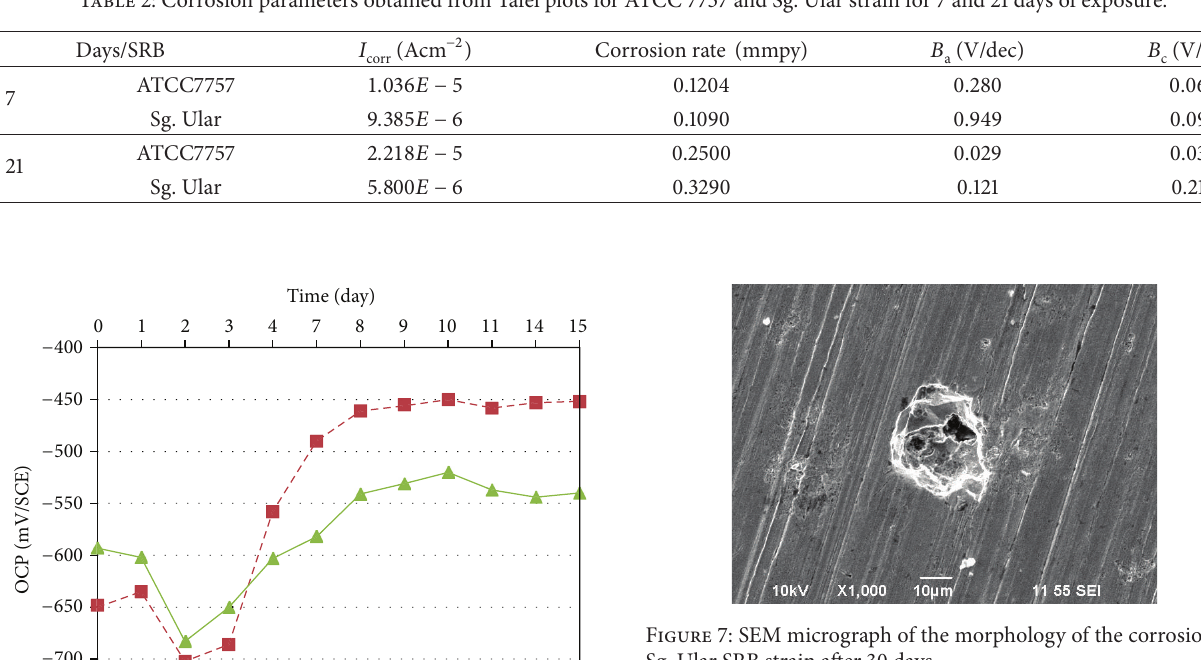
Table 2: Corrosion parameters obtained from Tafel plots for ATCC 7757 and Sg. Ular strain for 7 and 21 days of exposure.